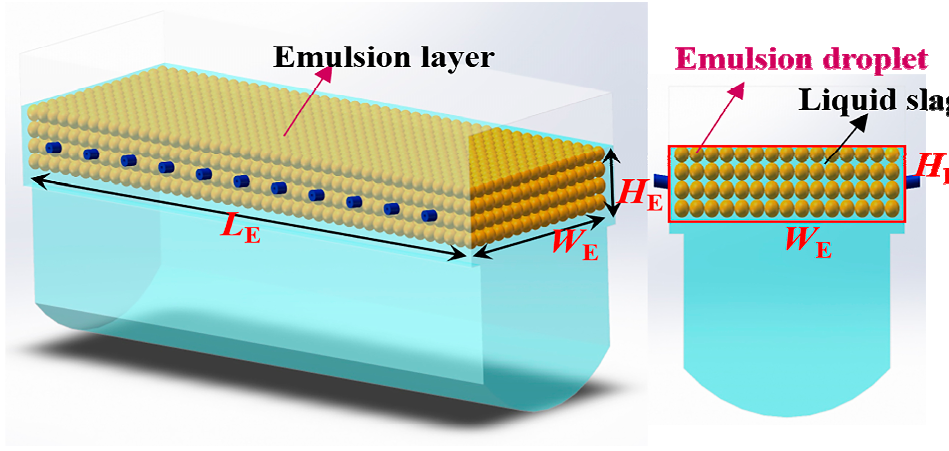
Figure 6. Estimation of the interfacial area of water–oil in the emulsion layer.